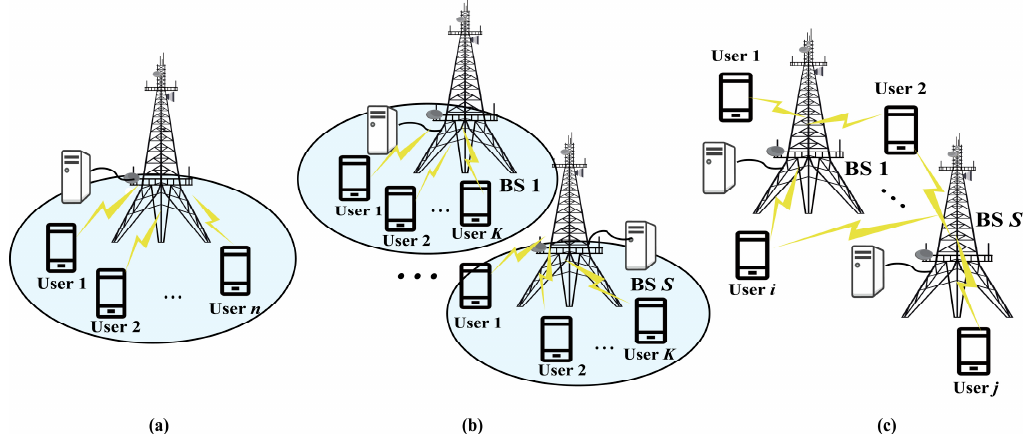
Figure 3. Di ff erent cell division scenarios: ( a ) single cell, ( b ) multiple cells and ( c ) cell-free.